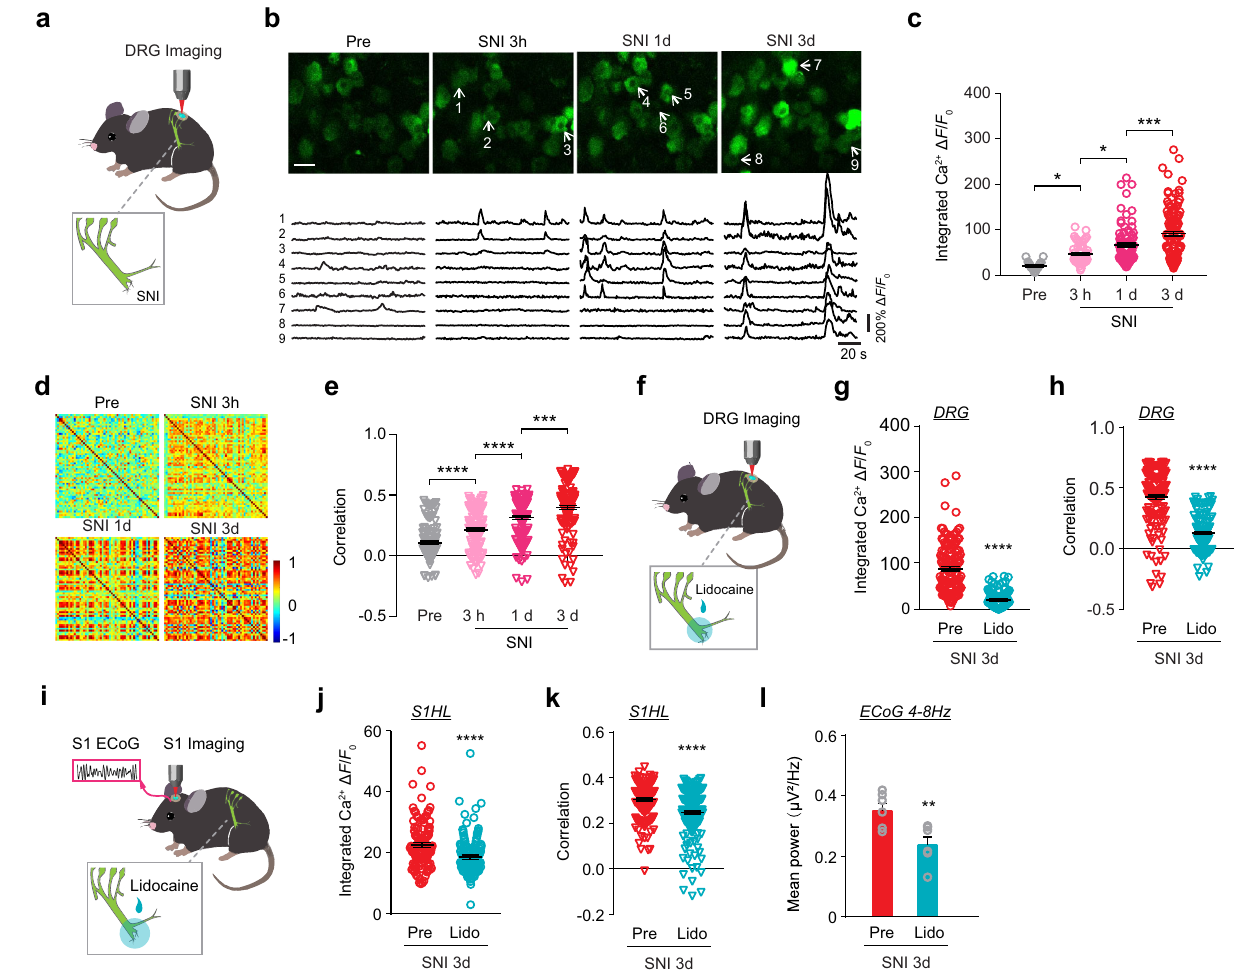
Fig.2|PeripheralnerveinjuryinducesactivitysynchronyinDRGneuronsprior topyramidalneuronsinS1.a SchematicshowingCa 2+ imagingofsensoryneurons in L4 DRG in awake mice. Gray inset: SNI surgery. b Representative two-photon images and fl uorescence traces of L4 DRG sensory neurons before, 3hours, 1 day, and 3 days after SNI. Arrows point to neurons with Ca 2+ traces shown below. Scale, 50 μ m. c The integrated Ca 2+ activity of active neurons in the DRG before, 3hours, 1 day, and 3 days after SNI surgery. d Representative correlation coef fi cient matrix ofcalciumtransientsfromallactiveneuronpairsinDRGbeforeandafterSNI. e The correlation coef fi cient of DRG neurons before and after SNI surgery. f Schematic showing Ca 2+ imaging of sensory neurons in L4 DRG in awake mice treated with